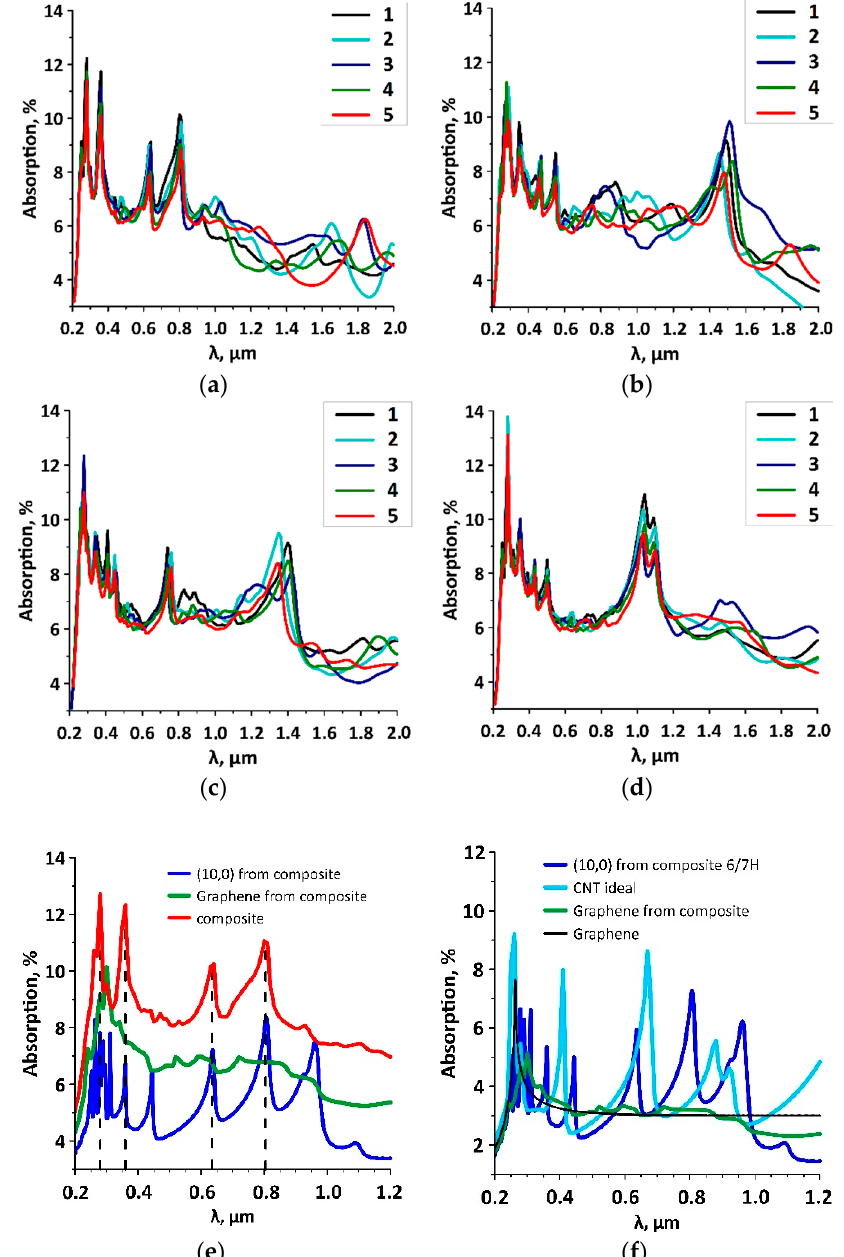
Figure 4. Absorption spectra of graphene/SWCNT composite films with different SWCNTs and distances H1/H2 between them: ( a ) film with SWCNTs (10,0), numbers 1–5 correspond to H1/H2 of 6/7–6/11 hexagons; ( b ) film with SWCNTs (12,0), numbers 1–5 correspond to H1/H2 of 7/8–7/12 hexagons; ( c ) film with SWCNTs (14,0), numbers 1–5 correspond to H1/H2 of 8/9–8/13 hexagons; ( d ) film with SWCNTs (16,0), numbers 1–5 correspond to H1/H2 of 9/10–9/14 hexagons; ( e ) film with SWCNTs (10,0) and H1/H2 6/7 hexagons film components; ( f ) graphene and SWCNT in the composite film with SWCNTs (10,0) and H1/H2 6/7 hexagons, ideal graphene and SWCNT.